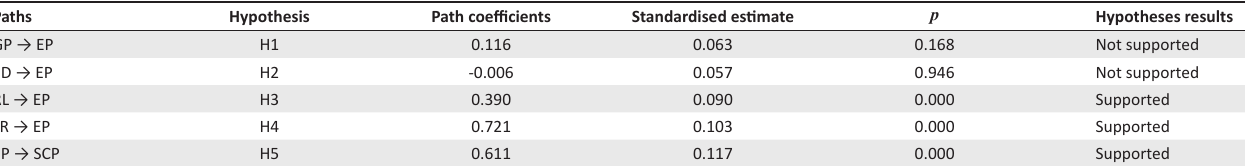
TABLE 6: Results of path